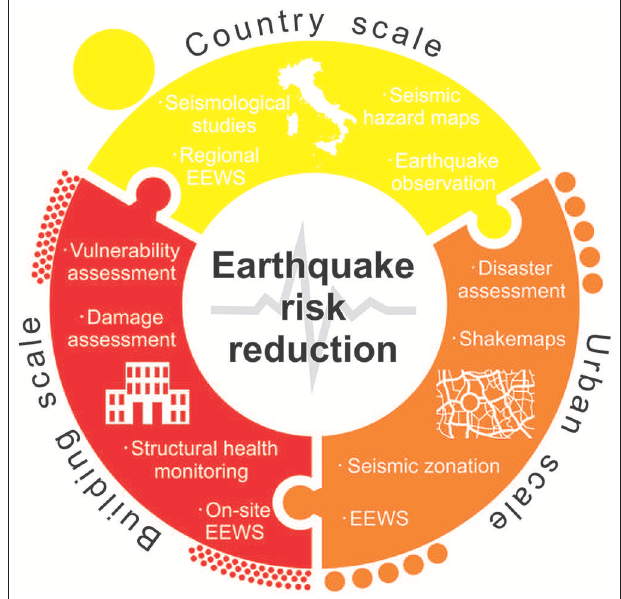
FIGURE 11 | Integrated multi-scale approach for earthquake risk reduction based on the three complementary monitoring systems, each involving different tasks in the pre-event, emergency, and post-event